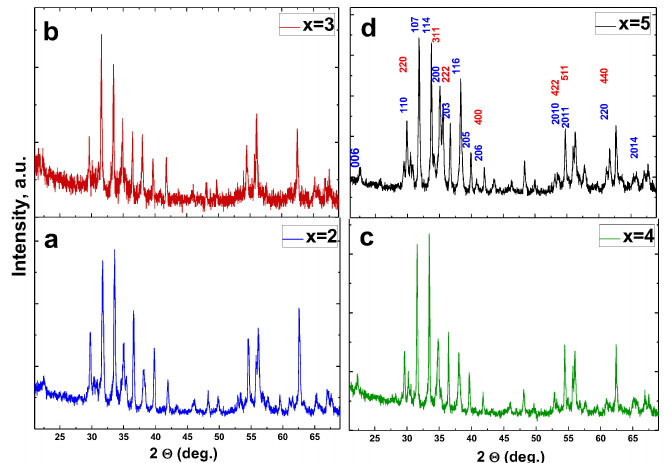
Figure 1. The X-ray diffraction powder patterns of the Sr 0.3 Ba 0.4 Pb 0.3 Fe 12 O 19 /(CuFe 2 O 4 ) x composite samples x = 2 ( a ), 3 ( b ), 4 ( c ), and 5 ( d